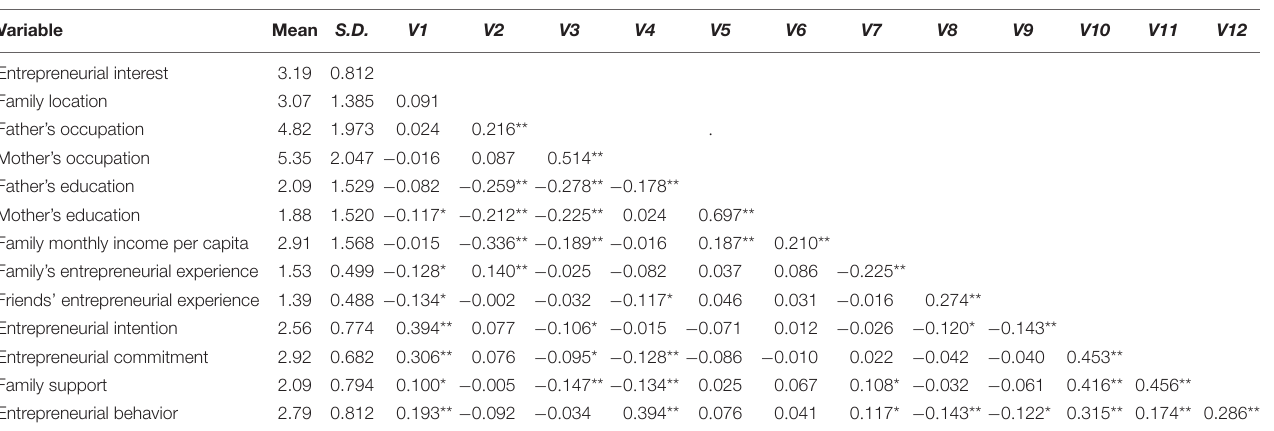
TABLE 3 | Correlation